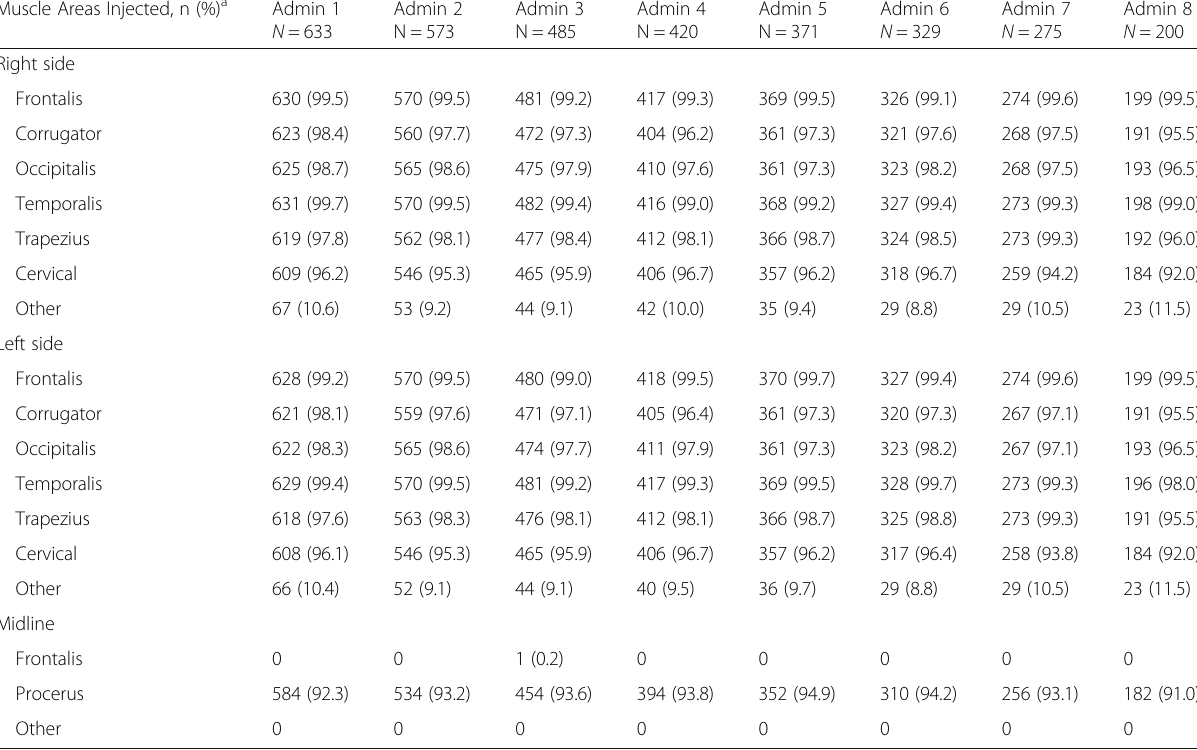
Table 3 Muscle Areas Injected With OnabotulinumtoxinA Stratified by Administration Session Muscle Areas Injected, n (%)